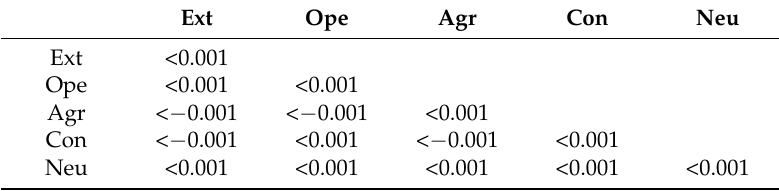
Table A3. Covariance Matrix of machine learning-derived Five Factor Models ( n = 13,497).